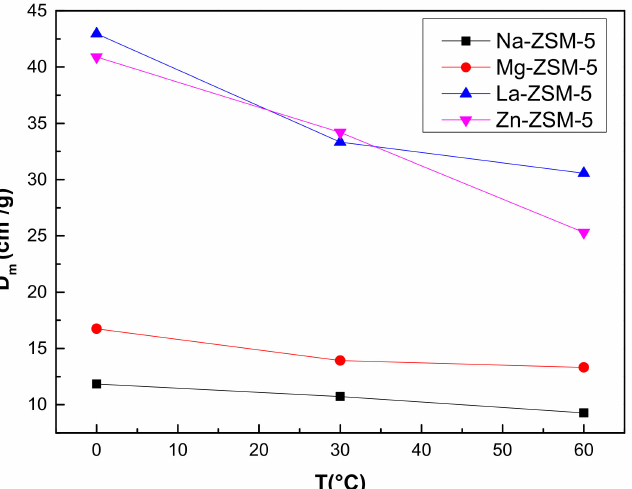
Figure 6. Effect of temperature on the density of receptor sites of the Na-ZSM-5, Mg-ZSM-5, La-ZSM-5 and